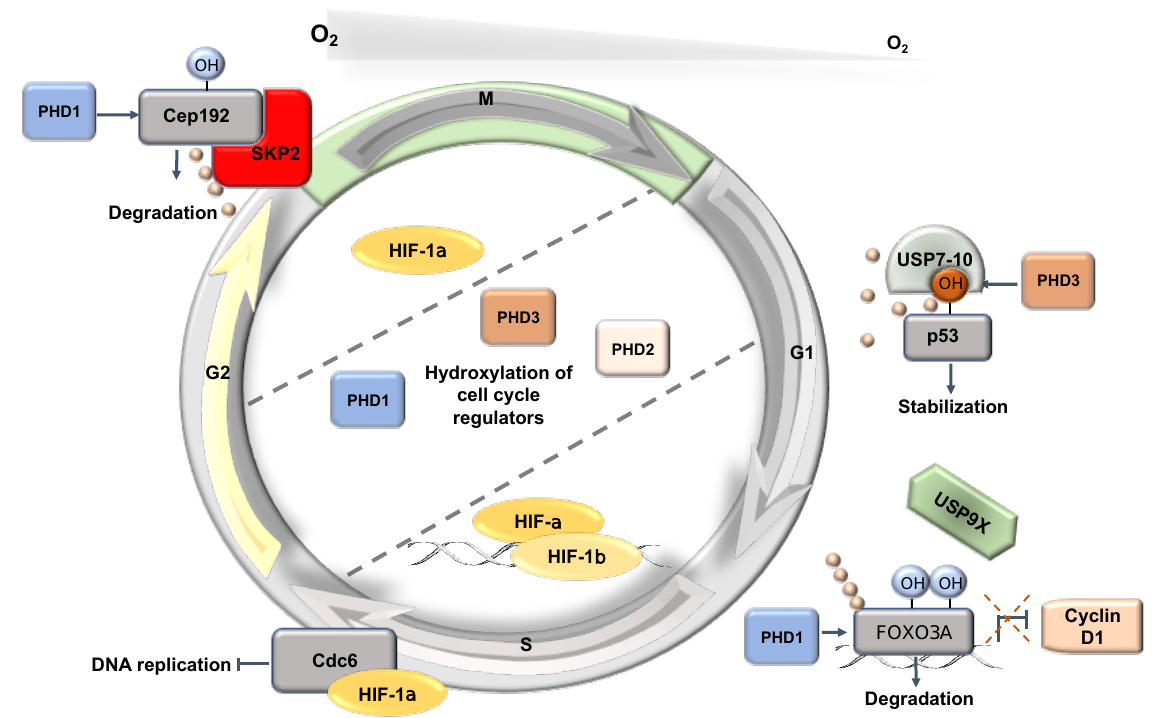
Figure 4. Hypoxia-induced post-transcriptional effects on the cell cycle. HIF has a non-transcriptional effect controlling DNA replication. In addition, PHD1 and PHD3 have non-HIF targets involved in the control of the cell cycle.